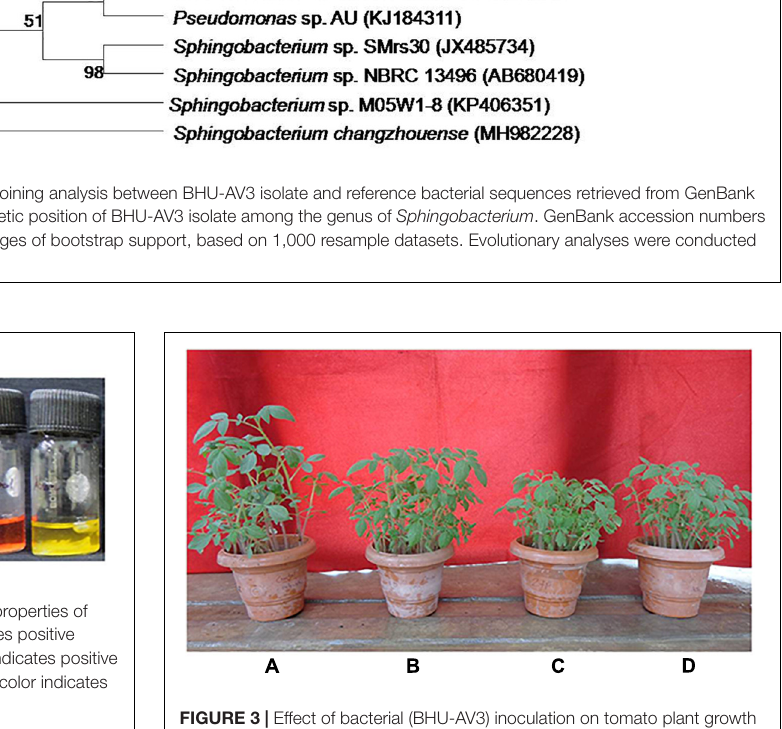
FIGURE 3 | Effect of bacterial (BHU-AV3) inoculation on tomato plant growth under salt stress. (A) Control plants; (B) bacteria (BHU-AV3)-inoculated plants; (C) salt (NaCl) treatment; (D) bacterial inoculation +